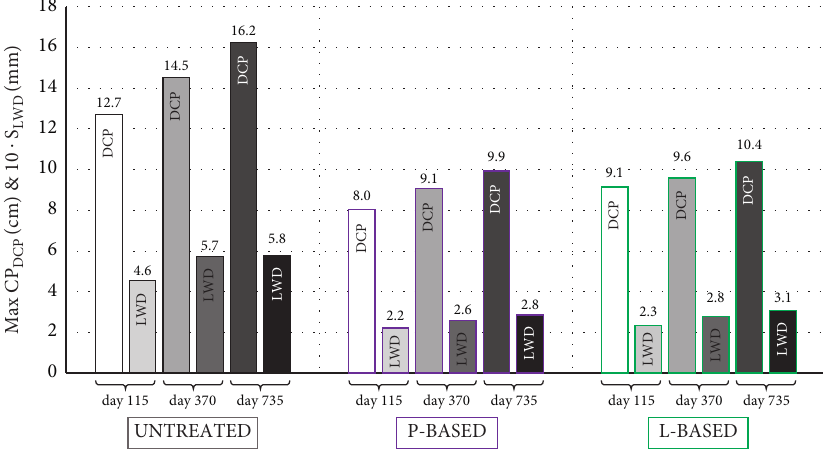
Figure 14: Values of maximum cumulative penetration CP